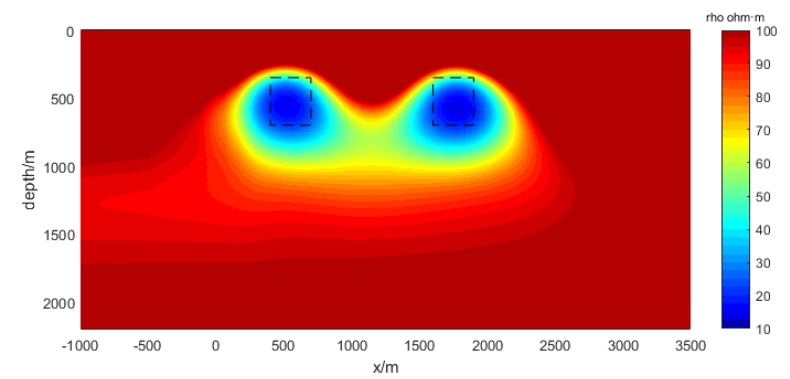
Figure 4. Inversion figure.